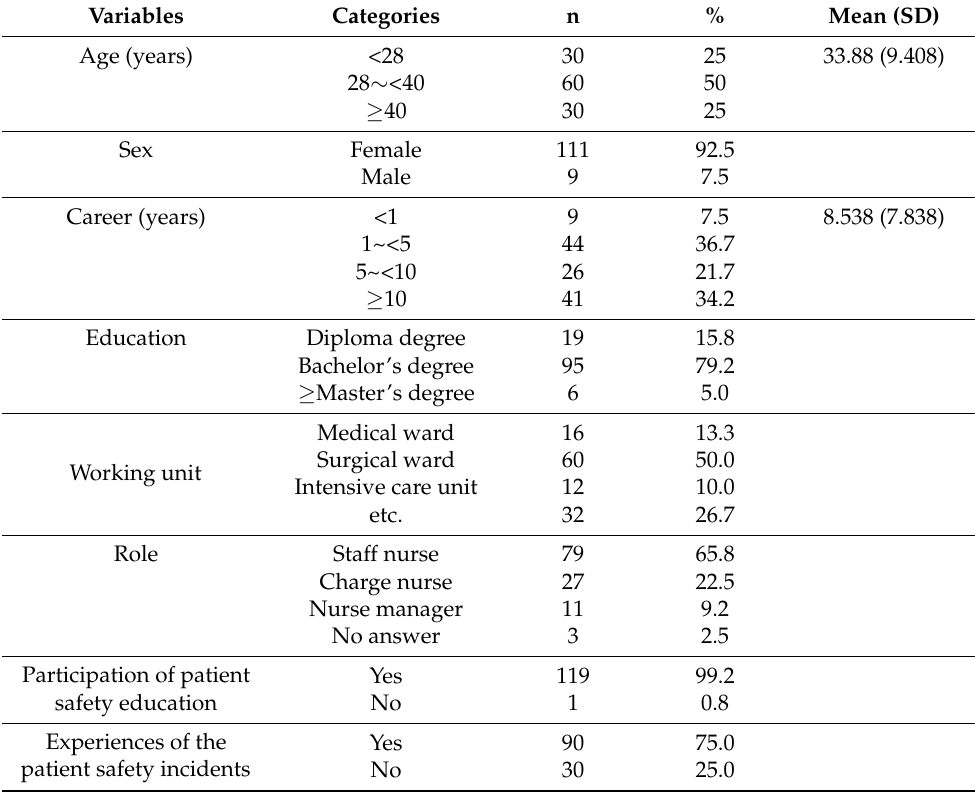
Table 1. General characteristics of participants (n = 120).